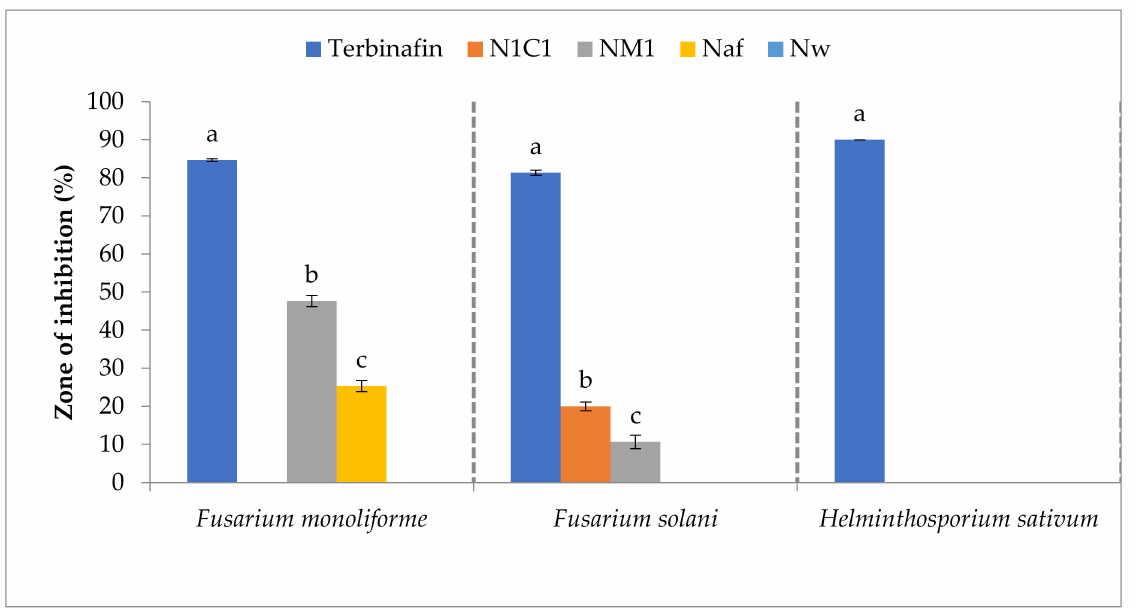
Figure 12. Antifungal activity of nanoparticles formed from bacterial strain N1C1, Fusarium oxysporum fungus, and methanolic and methanol water extracts of Aerva javanica (16 g/mL) against Fusarium moniliforme , Fusarium solani , and Helminthosporium sativum . N1C1— Bacillus subtilis ; NM1—methanolic extract of Aerva javanica; Naf— Fusarium oxysporum; Nw— Aqueous extract of aerial parts . Different letters are indicating significant differences ( p < 0.05) among